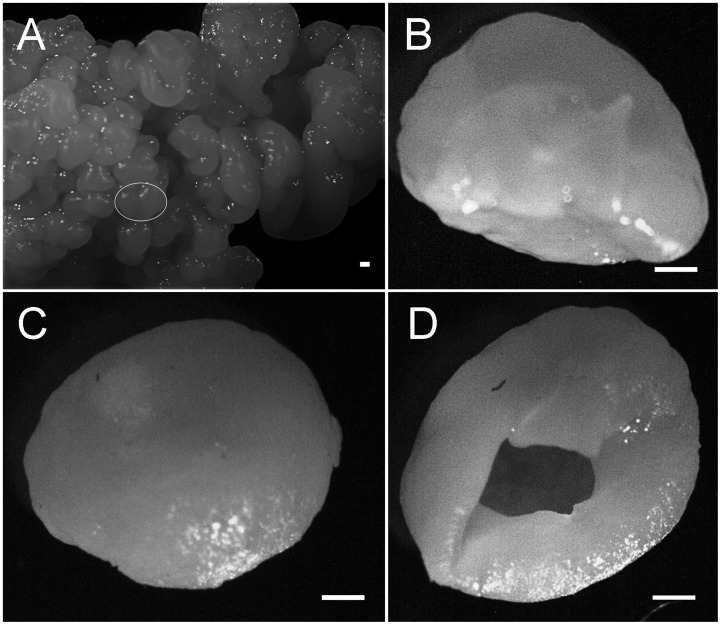
Stereomicroscope images of the Tibetan kefir grains.(A) Tibetan kefir grains and a single grain unit marked with a circle in (A) and observed from the side (B), the top (C), and the bottom (D). Scale bar = 1.2 mm.